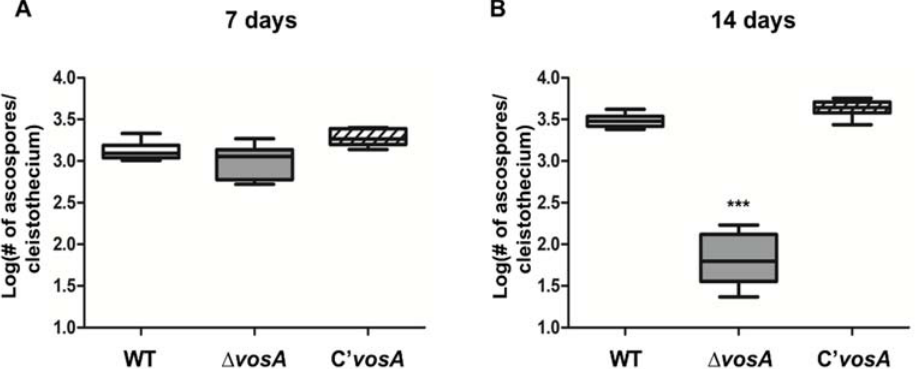
Figure 1. Viability of ascospores of the ∆ vosA mutant. ( A , B ) The number of colony-forming ascospores (log scale) per cleistothecium of wild type (WT) (FGSC 4), ∆ vosA (THS15.1), and C’ vosA (THS28.1) strains. Ten independent cleistothecium of WT were collected from plates cultured for 7 ( A ) or 14 ( B ) days. Ascospores from each cleistothecium were collected, spread onto MM solid media, and incubated for 48 h. Ascospore viability was estimated by counting the colony-forming units (WT vs. ∆ vosA , *** p < 0.001).